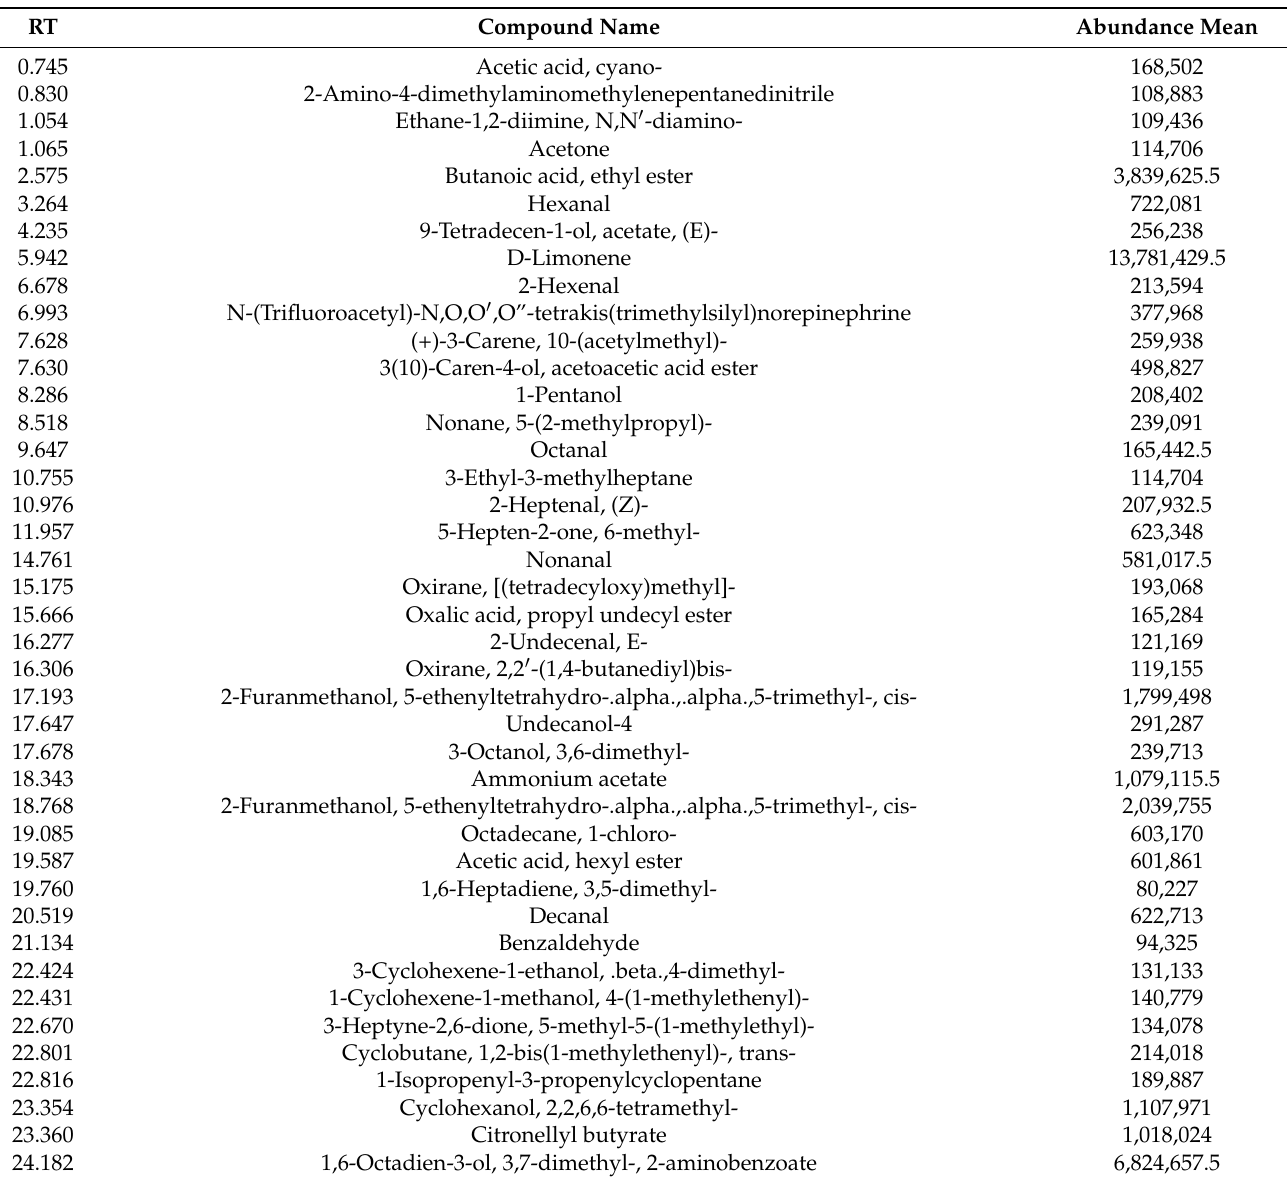
Table A1. Results for the TGO sample fingerprint determination with indication of the retention time (RT) and abundance mean for every identified